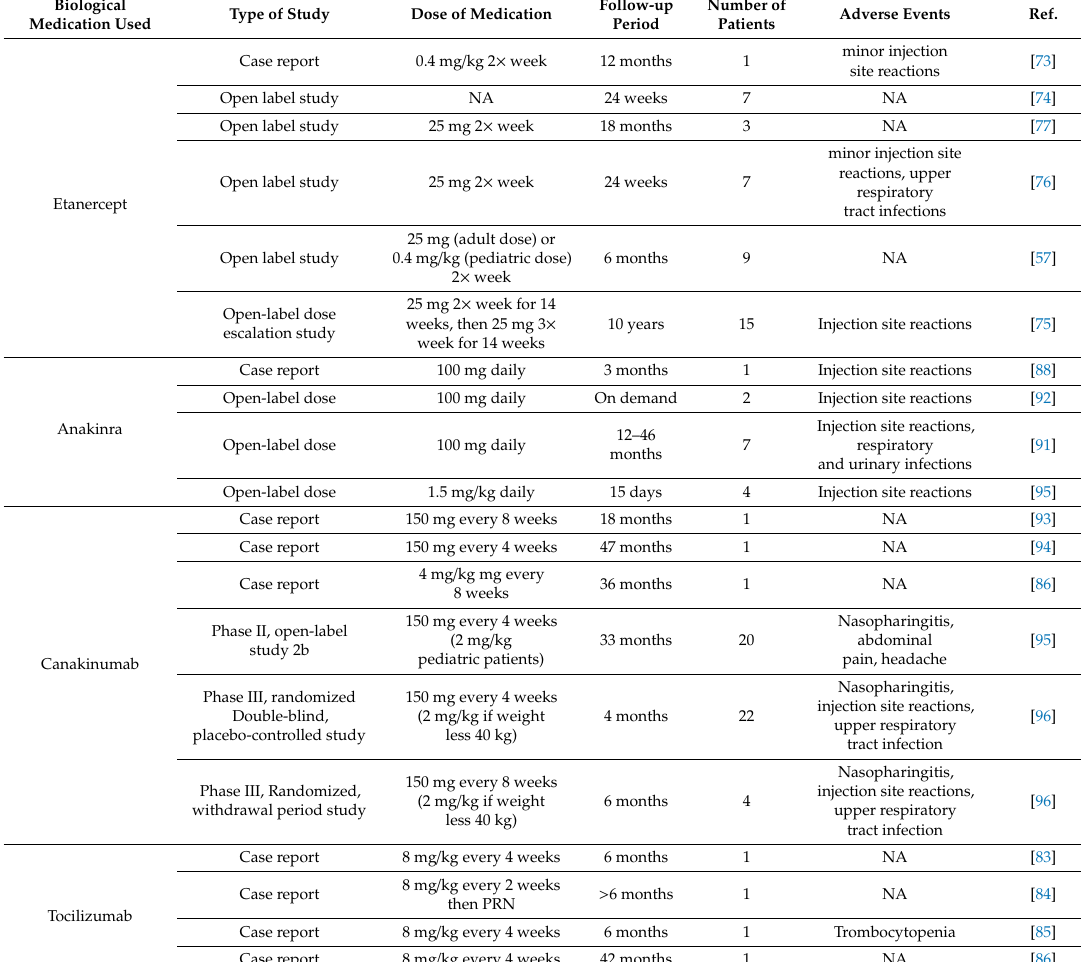
Table 1. Summay of studies that have investigated treatment of TRAPS with biological therapies: TNF inibitors, IL-1 inhibitors and Il-6